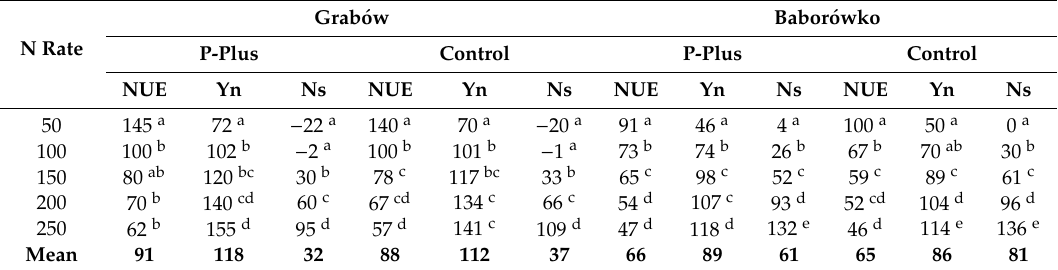
Table 5. N use indices for winter oilseed rape; N fertilizer rate, Yn (uptake), Ns (surplus) (kg · ha − 1 ); N use e ffi ciency (NUE) (%) for the P fertilizer addition (P-plus) and control (no P addition).